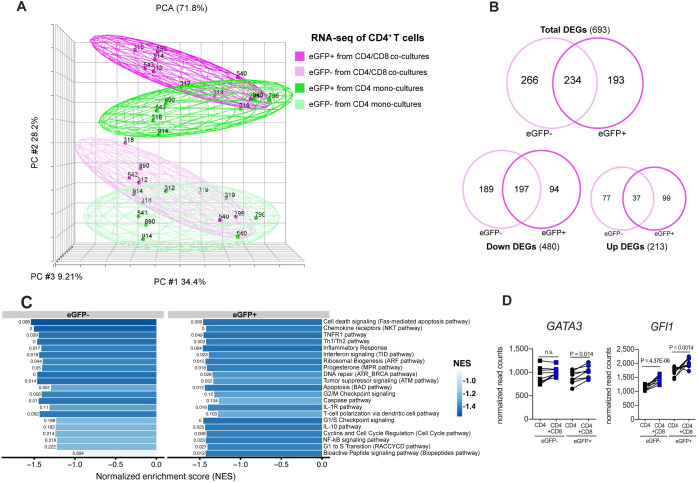
Transcriptome analysis of infected CD4+ T cells reveals systematic immune-suppressive activity by CD8+ T cells.All in vitro infections were conducted using the replication competent NL4-3_eGFP under single cycle condition with protease inhibitor (Darunavir). CD4+ T cells from mono- and co-cultures with CD8+ T cells at 1:1 E:T ratio were FACS-sorted based on eGFP+ and eGFP- expression 3 days post-infection (see S3 Fig). Data from 8 subjects are shown. (A) Principal-component analysis (PCA) of RNA-seq data shows CD4+ T sorted subsets derived from CD4 mono-cultures (eGFP-, light green; eGFP+; dark green) and CD4+ T sorted subsets derived from CD4/CD8 co-cultures (eGFP-, light magenta; eGFP+; dark magenta). Each point represents a sample labelled with the donor ID. Female subjects are indicated by circles, and male subjects are indicated by squares. (B) Venn diagrams demonstrating differentially expressed genes (DEGs) in eGFP- and eGFP+CD4+ T subsets in response to CD8+ T cells (DESeq2: padj <0.05 and fold change threshold >1.5 (0.585 log) or <0.67 (-0.585 log). Intersection shows DEGs in common between eGFP- and eGFP+CD4+ T subsets in response to CD8+ T cells. (C) Barplot shows the pathways significantly downregulated in eGFP- and eGFP+CD4+ T subsets by the CD8+ T cells obtained from the MSigDB database BioCarta collection, GSEA. A normalized enriched score (NES) lower than 0 corresponds to a pathway for which member genes are downregulated in CD4/CD8 co-cultures. The 21 pathways depicted presented a NES < -1.4 in either eGFP- or eGFP+CD4+ T subsets. The color scale denotes the maximum and minimum normalized enrichment score (NES), and the nominal p value alongside the bars, estimates the statistical significance of the enrichment score for a single gene set. For leading edge genes of Fas, Th1/Th2, Inflammatory and G2/M pathways (see S4 Fig). (D) Effect of CD8+ T cells on GATA3 and GFI1 transcriptional regulator genes associated with the Th2 pathway of CD4+ T helper differentiation (DESeq2 library size normalized read counts).